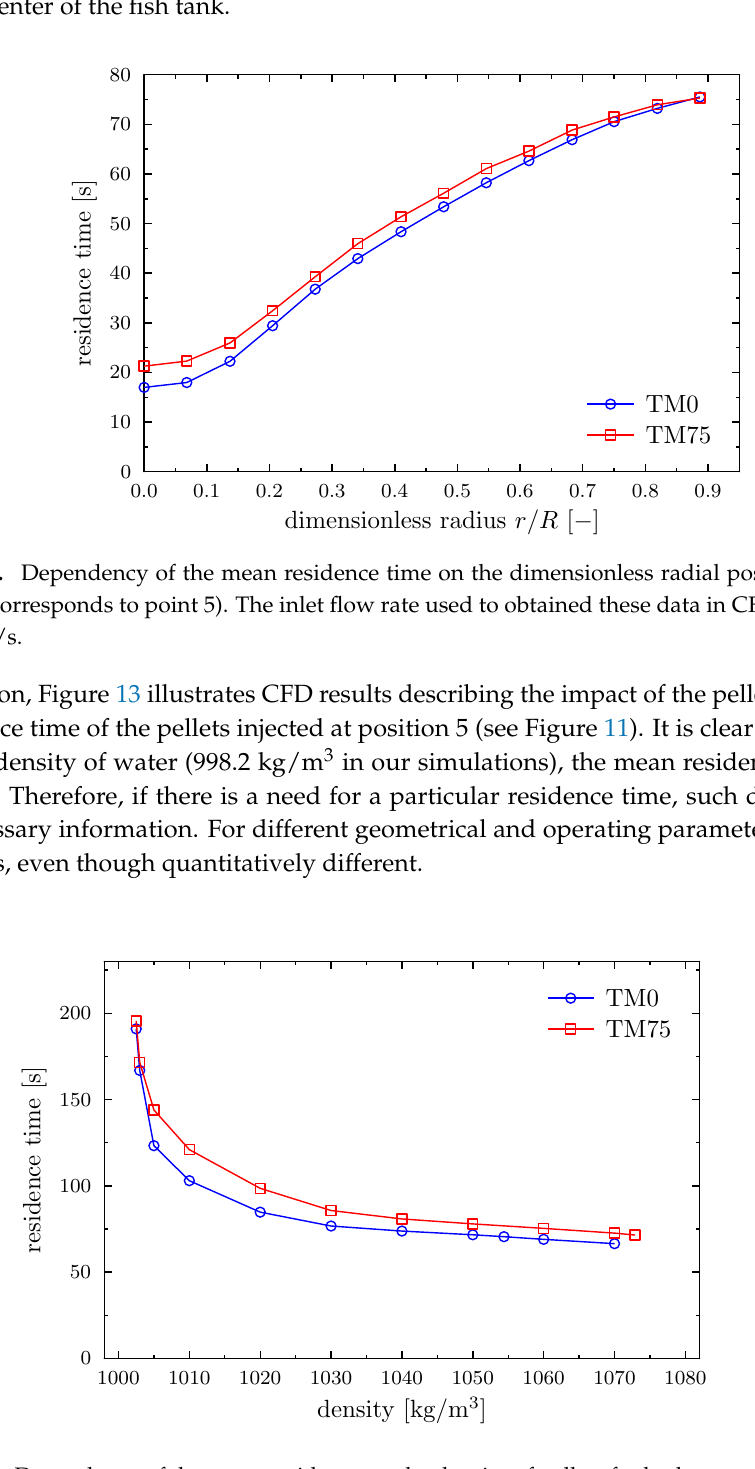
Figure 13. Dependency of the mean residence on the density of pellets for both types of pellets, TM0 and TM75. The injection position corresponded to number 5 (see Figure 11), that is on the opposite side of the water inlet. The inlet flow rate used to obtain these data in CFD simulations was 0.5